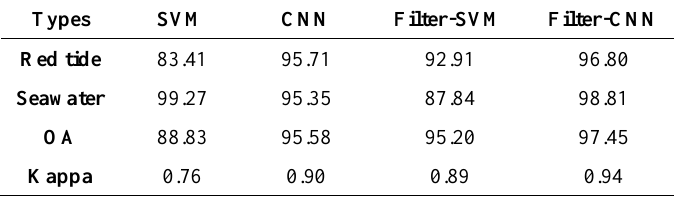
Table 1 The red tide detection accuracy